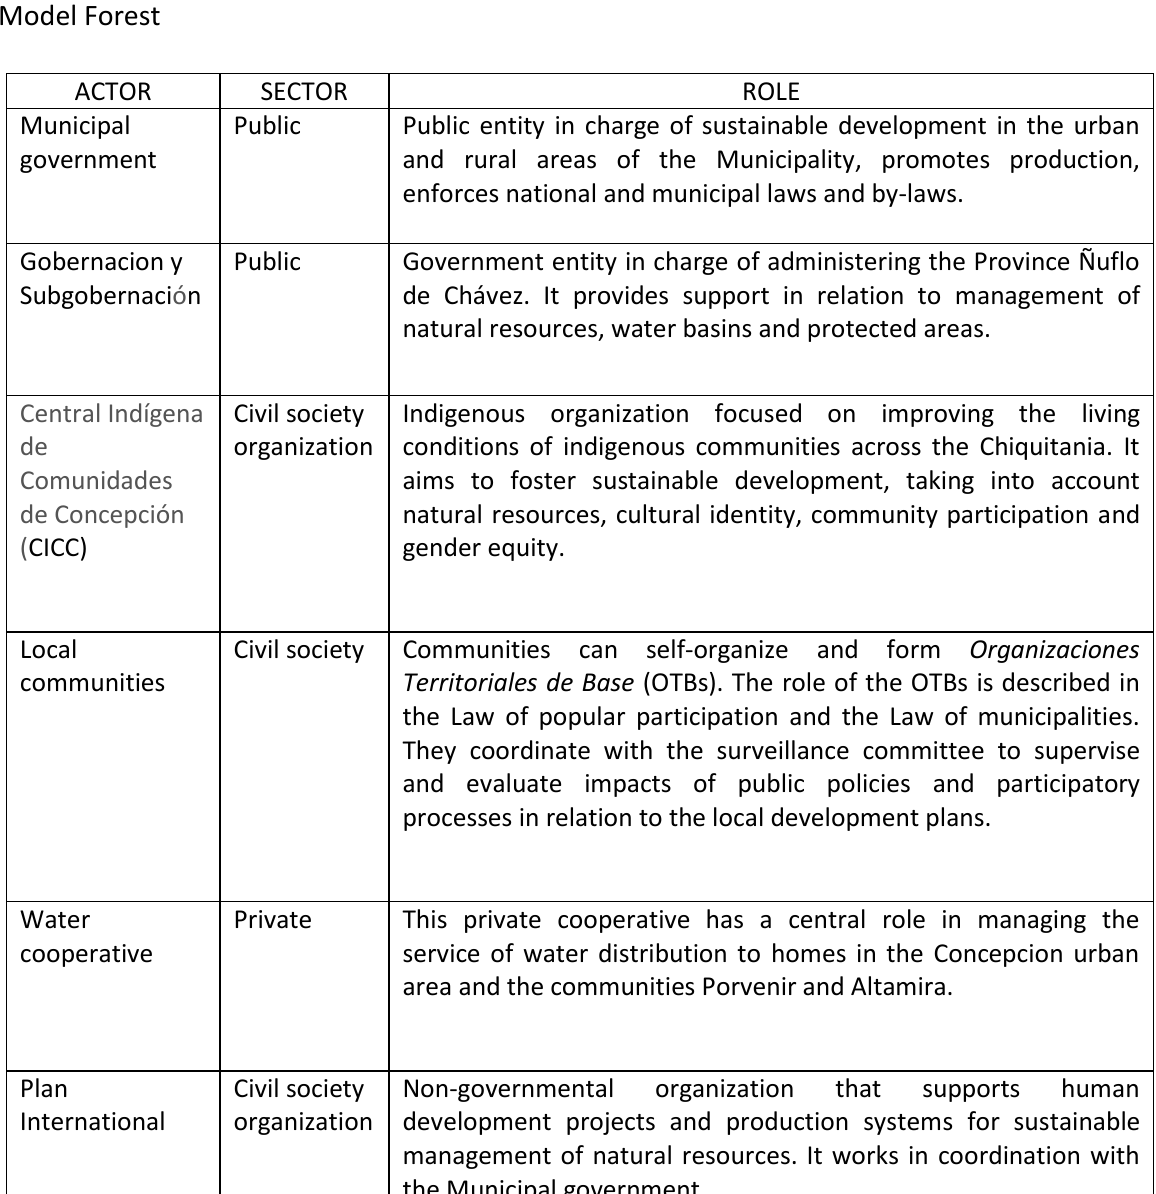
Table A3.3. Main actors and perceived roles in the water governance network of the Chiquitano Model